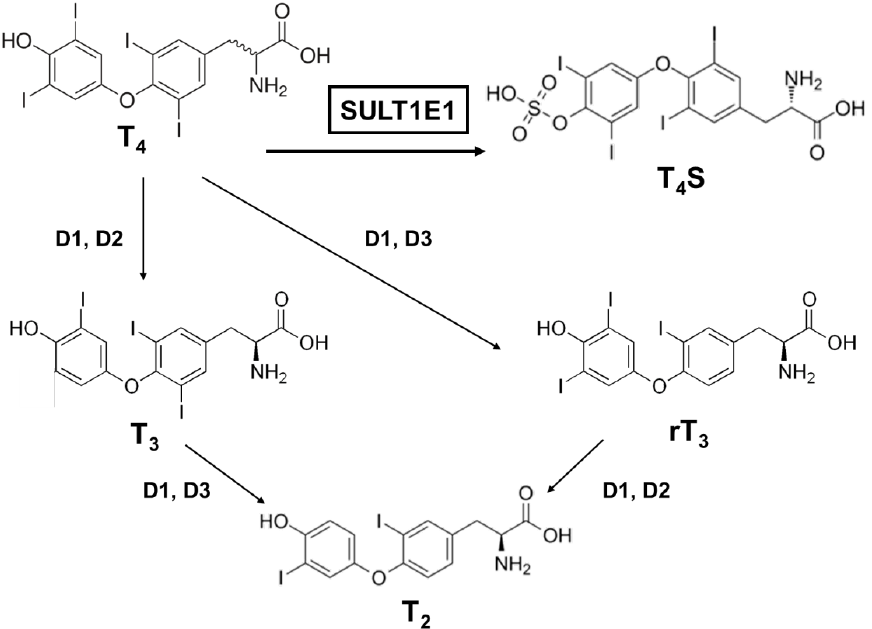
Figure 2. A schematic metabolic pathway of thyroid hormones. T 4 , thyroxine (prohormone); T 4 S, thyroxine sulfate (sulfoconjugated metabolite); T 3 , 3.3 (cid:48) ,5-triiodothyronine (receptor active iodothyro- thyroxine sulfate (sulfoconjugated metabolite); T 3 , 3.3′,5-triiodothyronine (receptor active iodothy- nine); rT 3 , 3.3 (cid:48) ,5 (cid:48) -triiodothyronine (receptor inactive iodothyronine); T 2 , 3.3 (cid:48) ronine); rT 3 , 3.3′,5′-triiodothyronine (receptor inactive iodothyronine); T 2 , 3.3′-diiodothyronine.